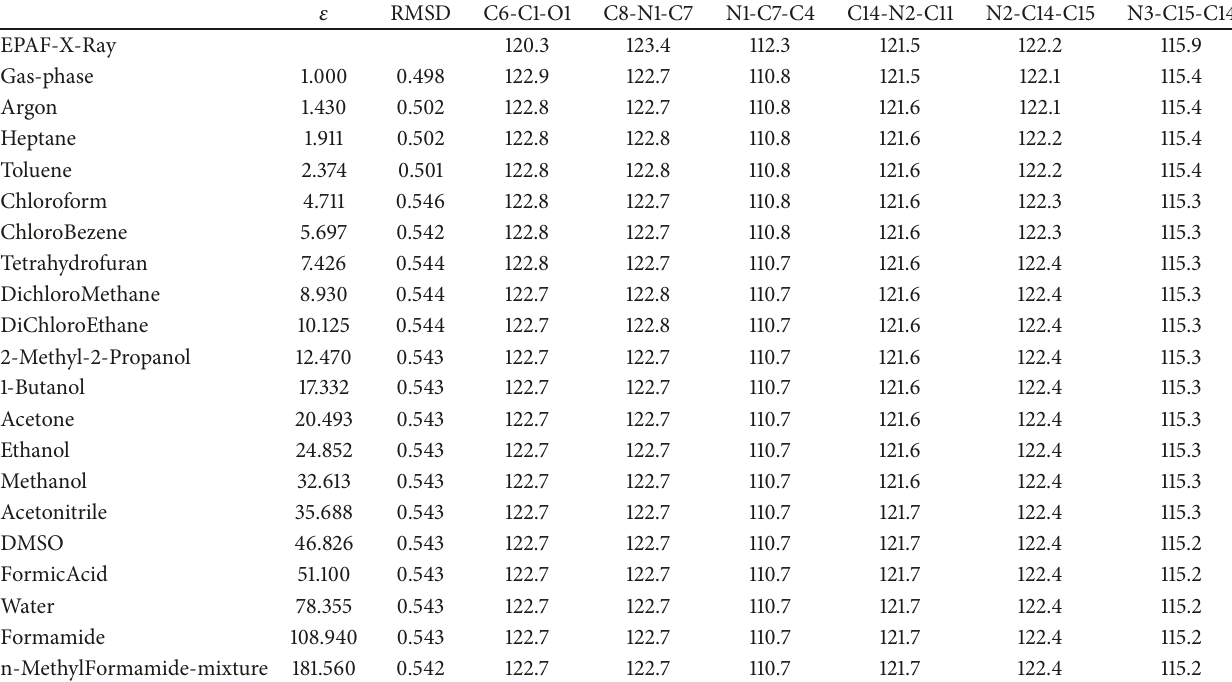
Table 3: Comparison of selected geometric data for EPAF ( ∘ ) from calculated DFT-Solvent and X-ray